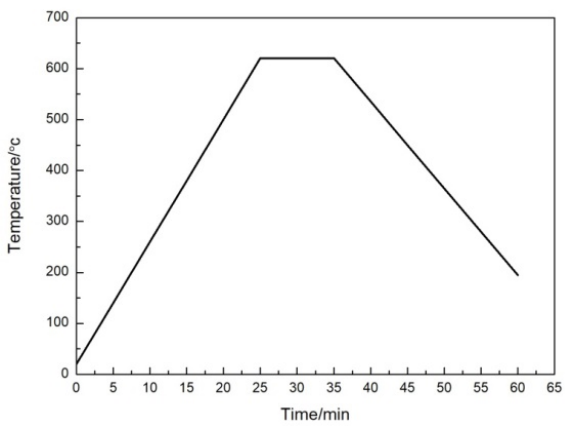
Figure 2. Sintering curve of aluminum electrode at 620 ℃ in